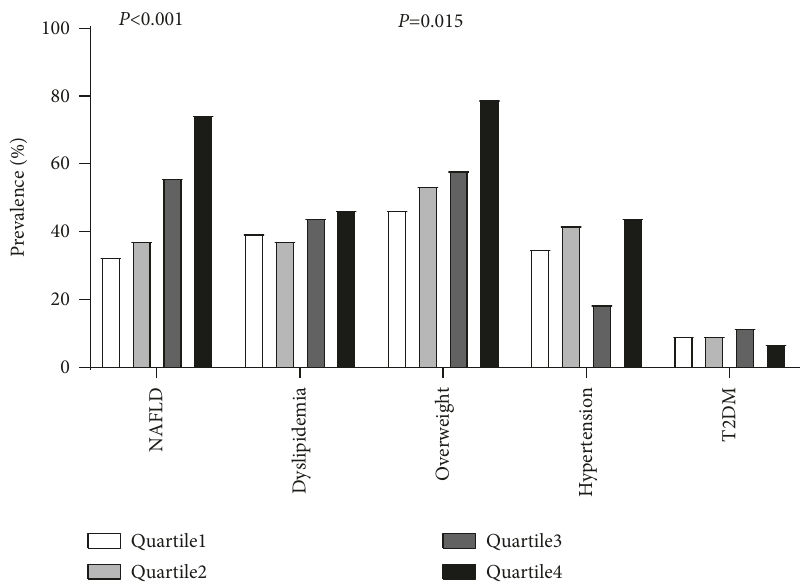
Figure 1: Prevalence of NAFLD, dyslipidemia, overweight, hypertension, and T2DM according to quartiles of the serum afamin levels. Participants were classified into quartiles according to their serum afamin levels. Quartile 1 < 9.78mg/L, 9.78 ≤ Quartile 2 < 12.14mg/L, 12.14 ≤ Quartile 3 < 15.29 mg/L, and Quartile 4 ≥ 15.29mg/L. NAFLD � nonalcoholic fatty liver disease; T2DM � type 2 diabetes mellitus. P- trend was calculated by the Cochran–Armitage χ 2 test for the trend. Table 3: Logistic regression analysis of NAFLD with the anthropometric and biochemical variables.